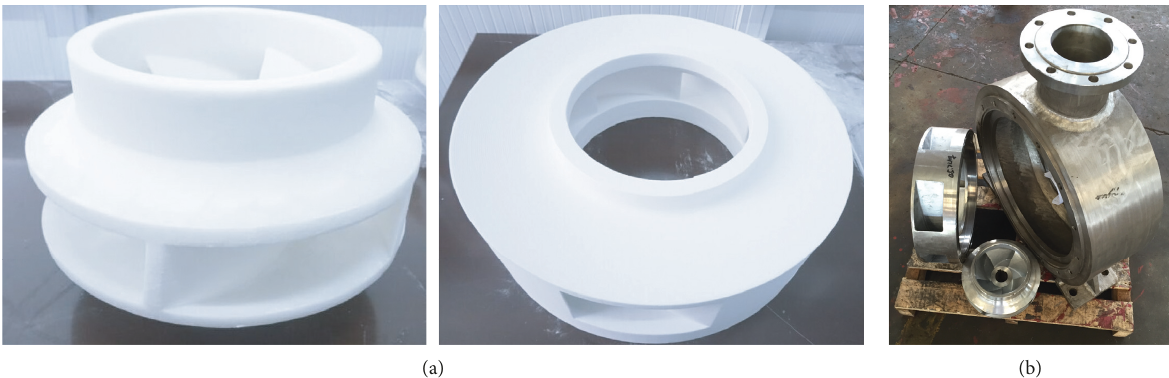
Figure 2: Component of centrifugal pump. (a) Wax models of impeller and vaned diffuser. (b) Component after casting.